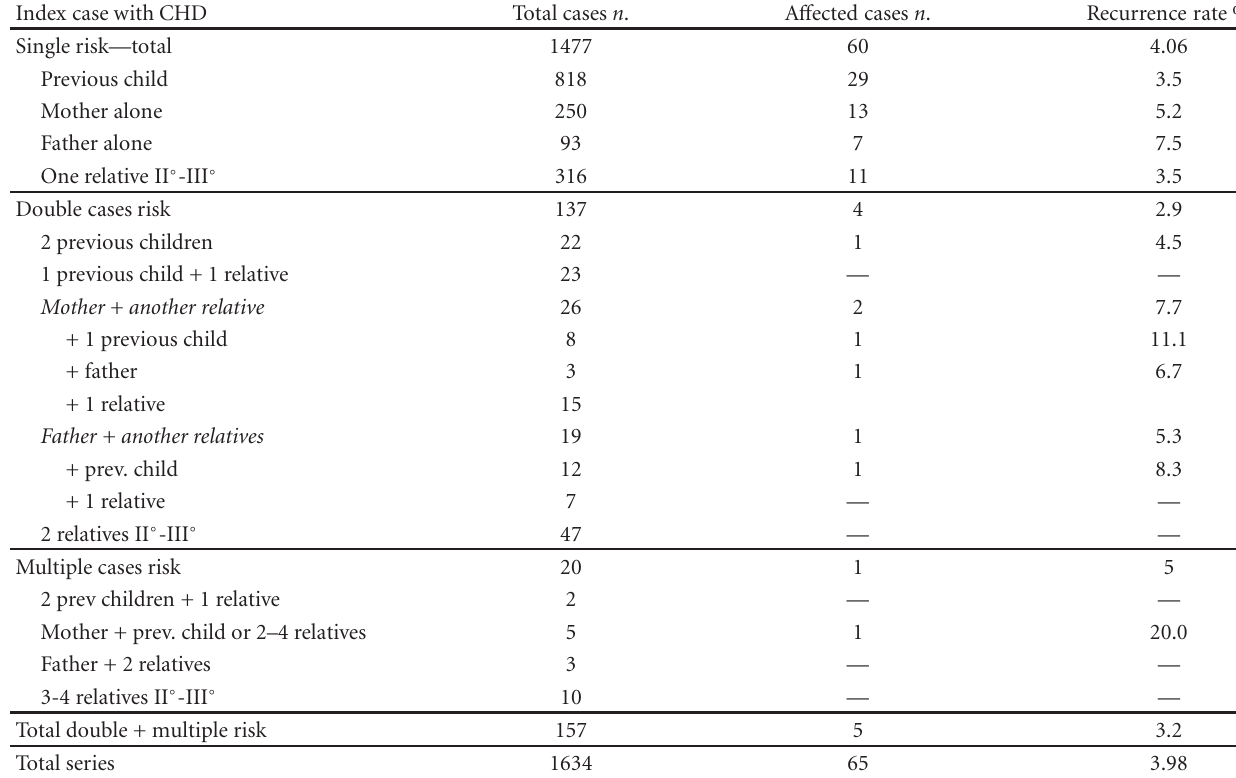
Table 1: Recurrence of congenital heart defects in cases with single- and multiple-familial